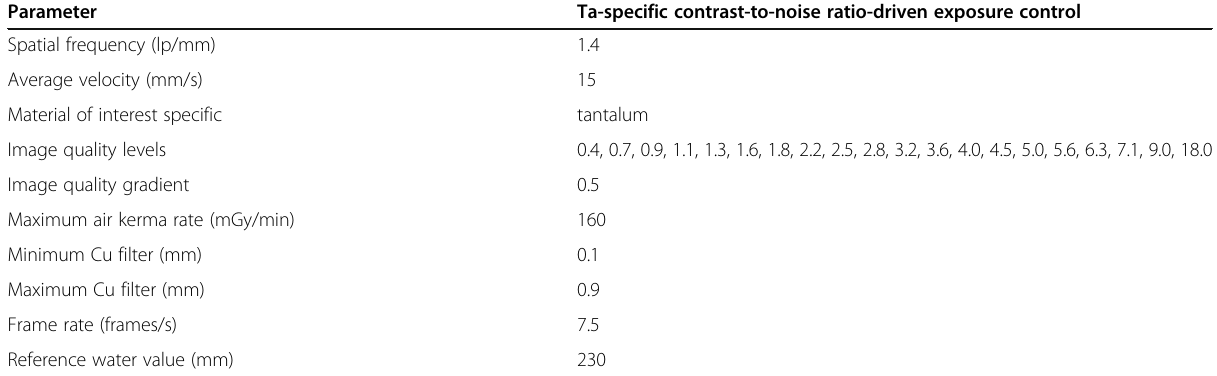
Table 2 Fluoroscopic image acquisition protocols of the Ta-specific contrast-to-noise ratio-driven exposure control Parameter Ta-specific contrast-to-noise ratio-driven exposure control Spatial frequency (lp/mm) 1.4 Average velocity